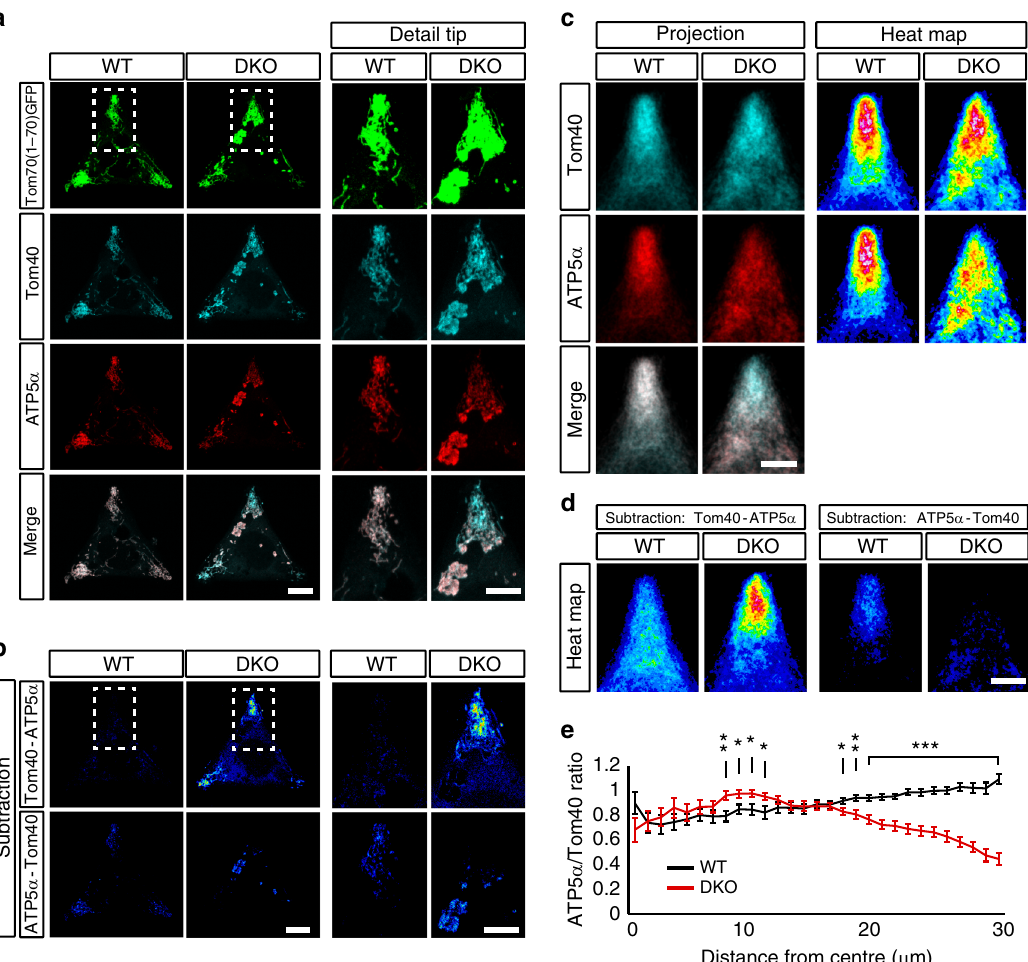
Fig. 7 Miro links the microtubule transport pathway to the MICOS complex through TRAK. a Quanti fi cation of the distribution of OMM and IMM components upon TRAK1/KIF5C overexpression in micropatterned substrates. WT and MiroDKO cells expressing the Tom70(1 – 70) GFP together with the mitochondrial motor machinery TRAK1/KIF5C were grown in “ Y ” -shaped micropatterns to produce triangular cells. Cells were immunostained for endogenous expression of an OMM marker (Tom40: cyan) and an IMM marker (ATP5 α : red), (scale bar: 10 μ m; insets: 5 μ m). b Cell representations